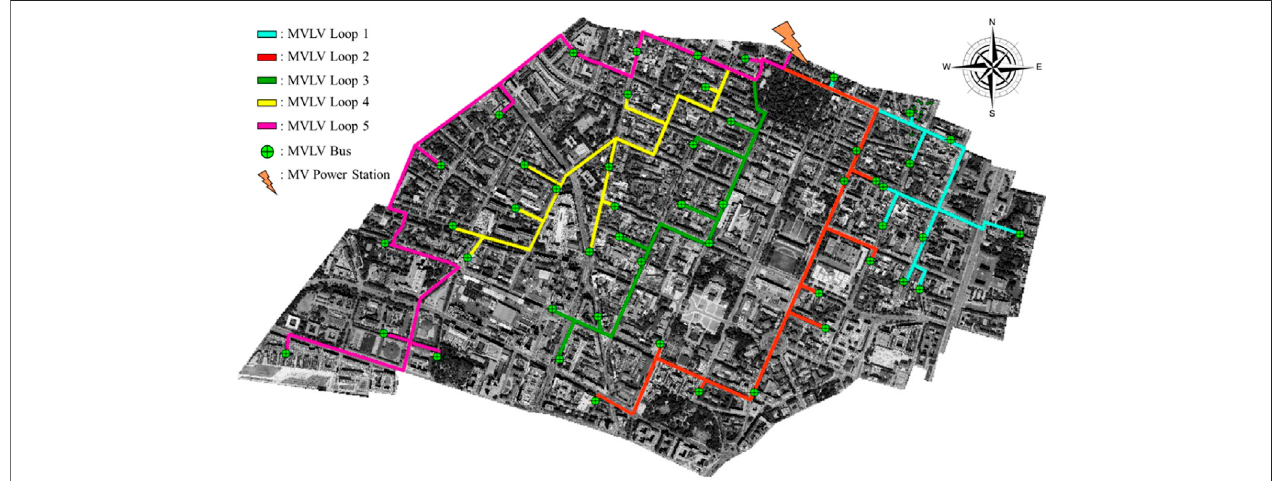
FIGURE 4 | Final electrical distribution network